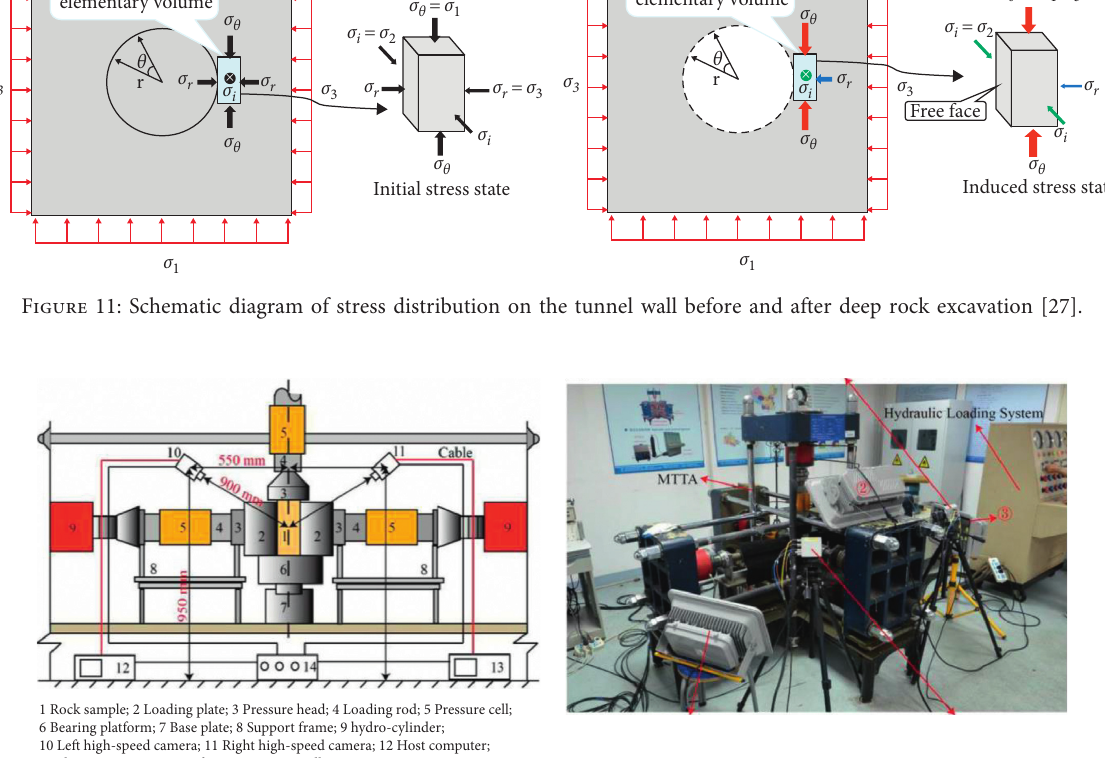
1 Rock sample; 2 Loading plate; 3 Pressure head; 4 Loading rod; 5 Pressure cell; 6 Bearing platform; 7 Base plate; 8 Support frame; 9 hydro-cylinder;